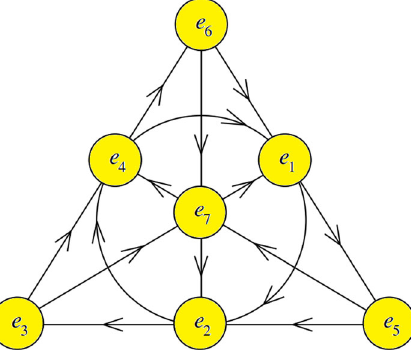
Fig. 1 Octonion multiplication represented using a Fano plane